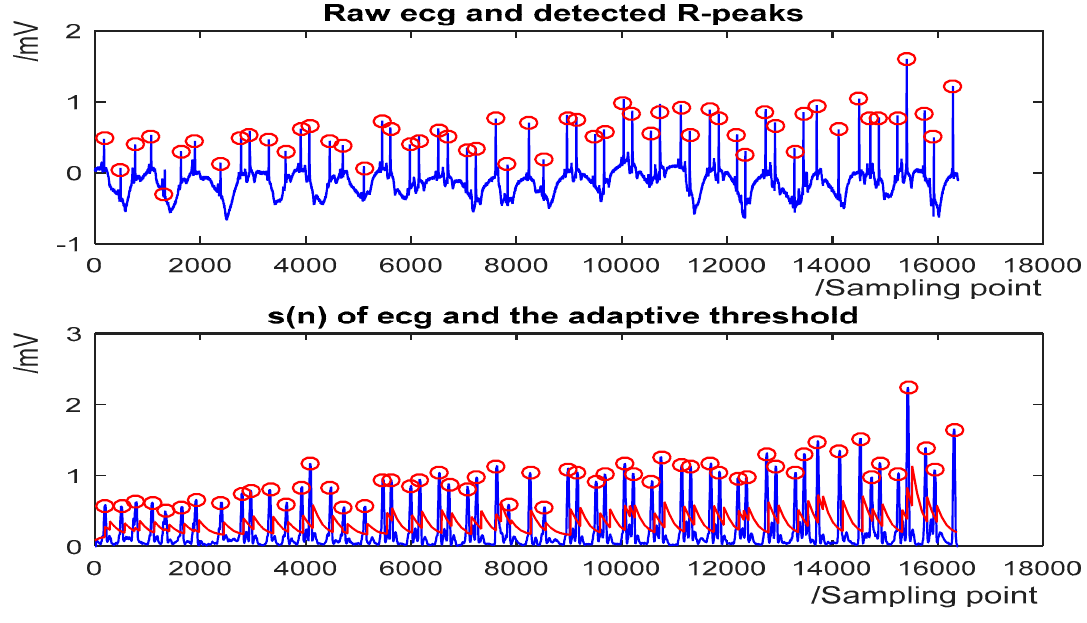
Figure 6. The QRS detection result of record 222 in the MIT-BIH Arrhythmia Database with noise and baseline wander. ( Top ) the original ECG and detected R-peaks (red circle). ( Bottom ) s(n) in record 222 and the threshold (red line).